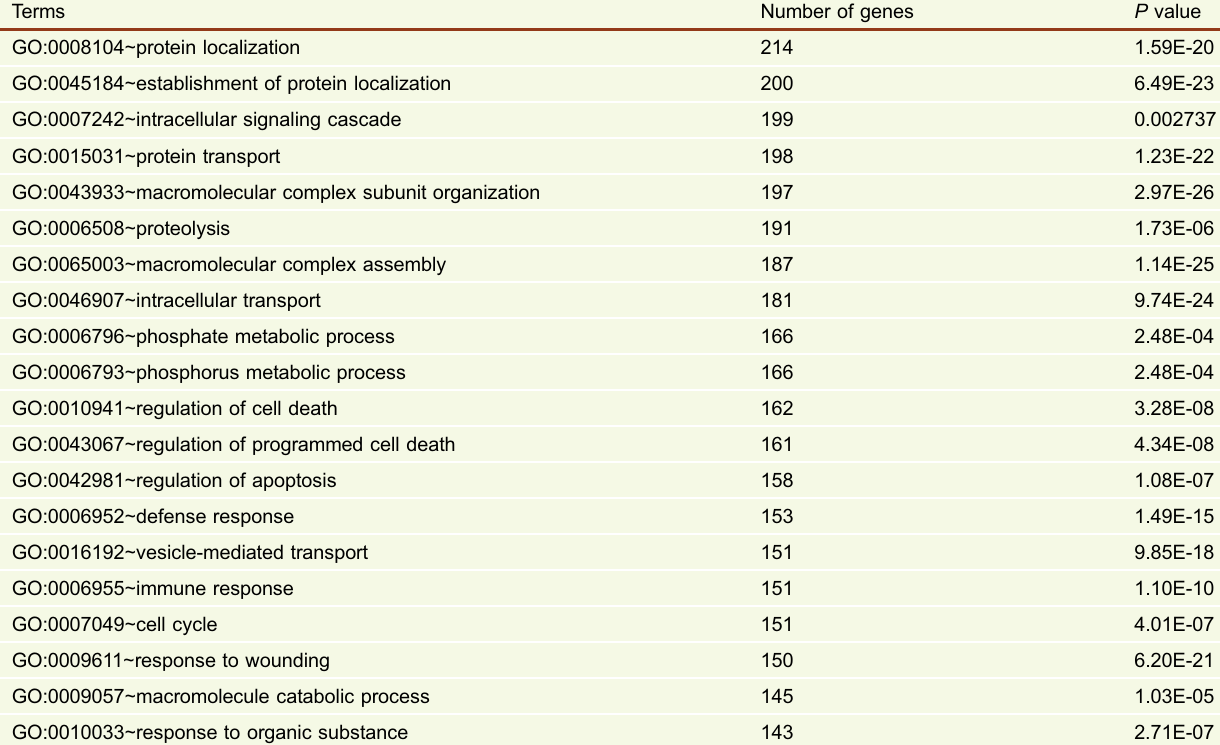
Table 2. 20 main biological processes related to